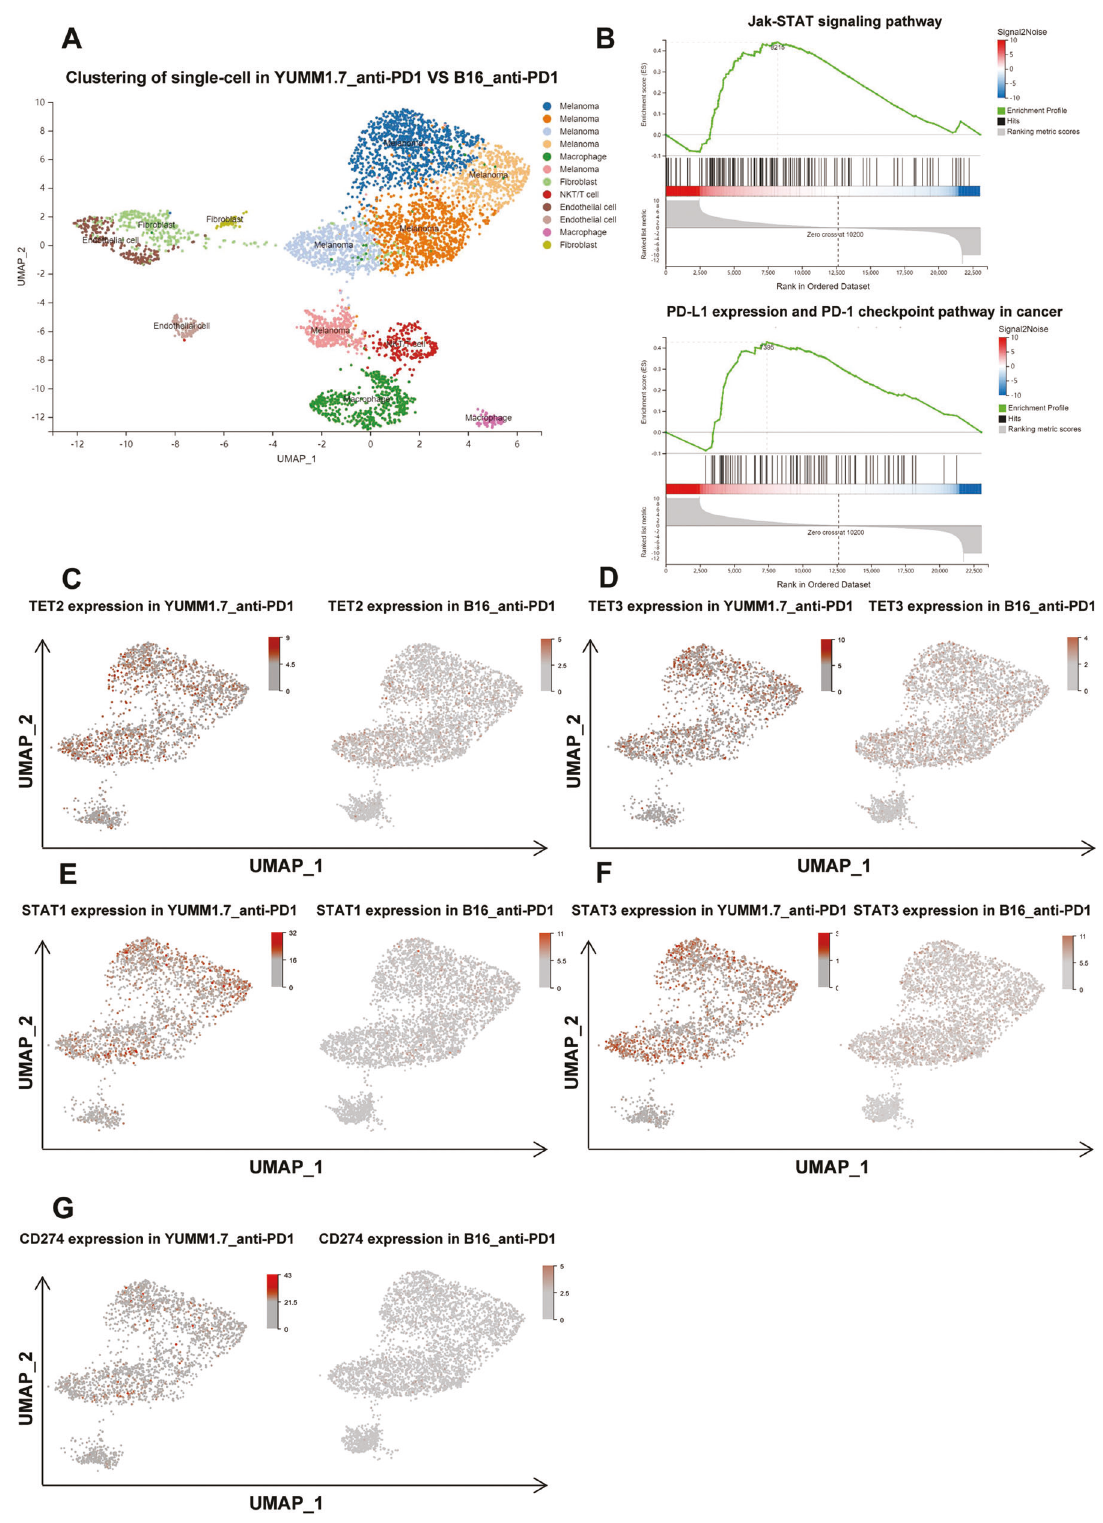
Fig. 3 TET2/3-STAT1/3-CD274 signaling was upregulated in tumors of mice that responded to anti-PD1 treatment. A Plot of Uniform manifold approximation and projection (UMAP) for anti-PD1 treatment pro fi les (number of tumors from B16F10 tumor-bearing mice: n = 2 and number of tumors from Yumm1.7 tumor-bearing mice: n = 2; n = 21 516 cells), with color coding indicating cell clusters. B Enrichment map of GSEA signaling pathway enriched in Yumm1.7_ anti-PD1 group compared to B16F10_ anti-PD1 group. C – E , Gene expression in Yumm1.7_ anti-PD1 or B16F10_ anti-PD1 single cell clusters.